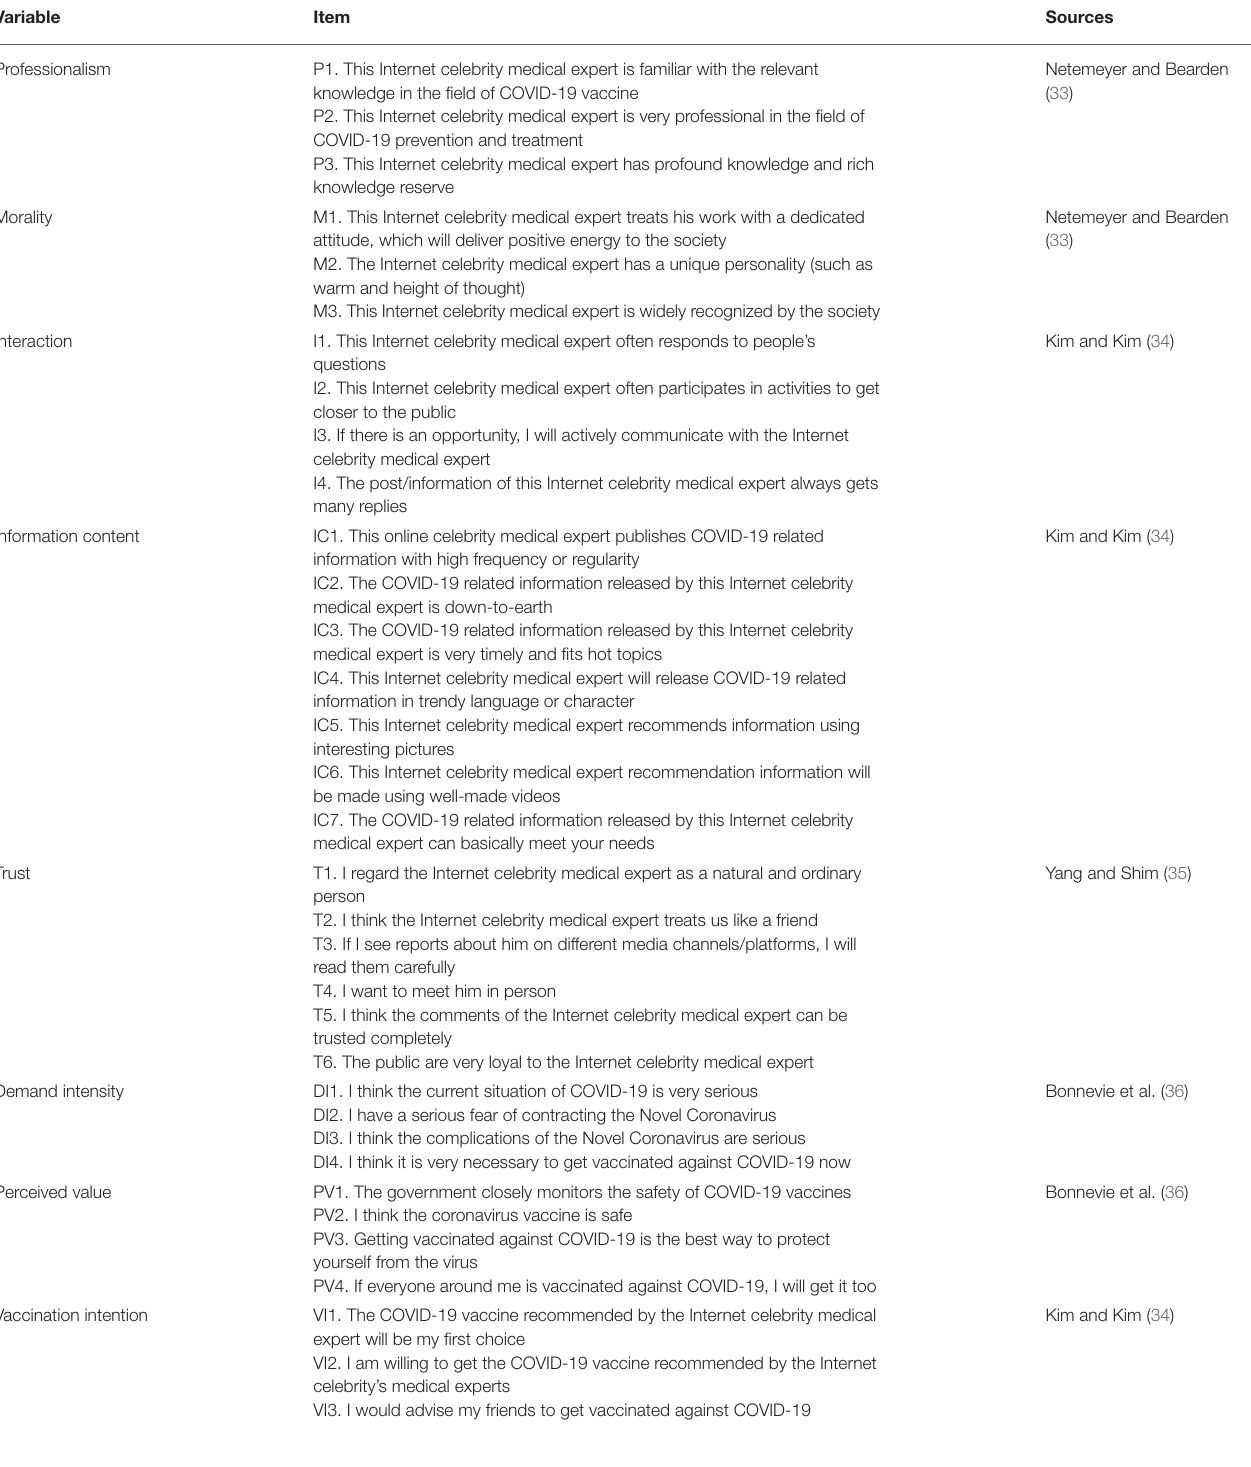
TABLE 1 | Variable measuring